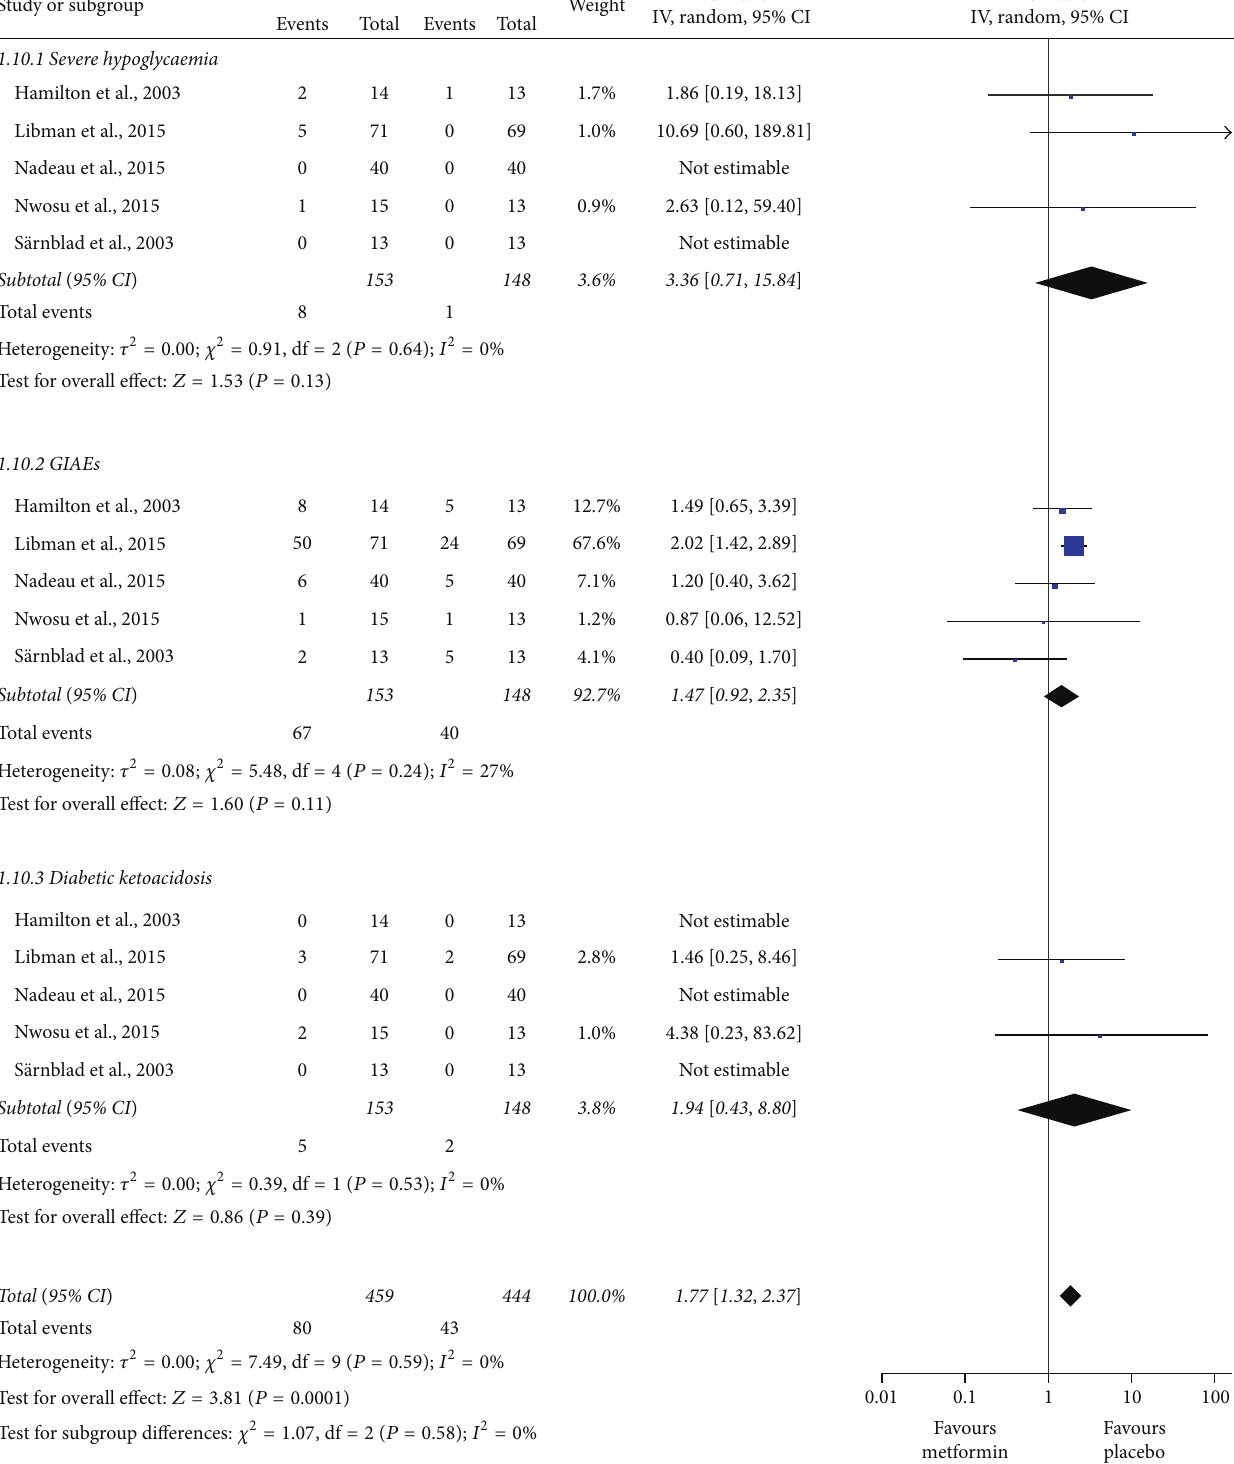
Figure 6: Meta-analysis of adverse events between patients who received adjunctive metformin therapy or placebo in adolescents with type 1 diabetes mellitus. CI: confidence interval; GIAEs: gastrointestinal adverse events; IV: inverse